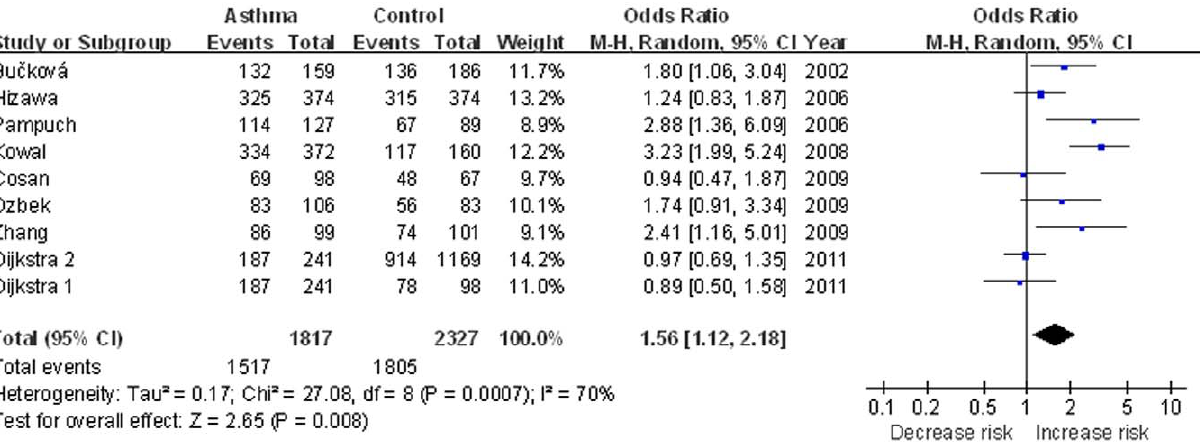
listed in Table S2 .